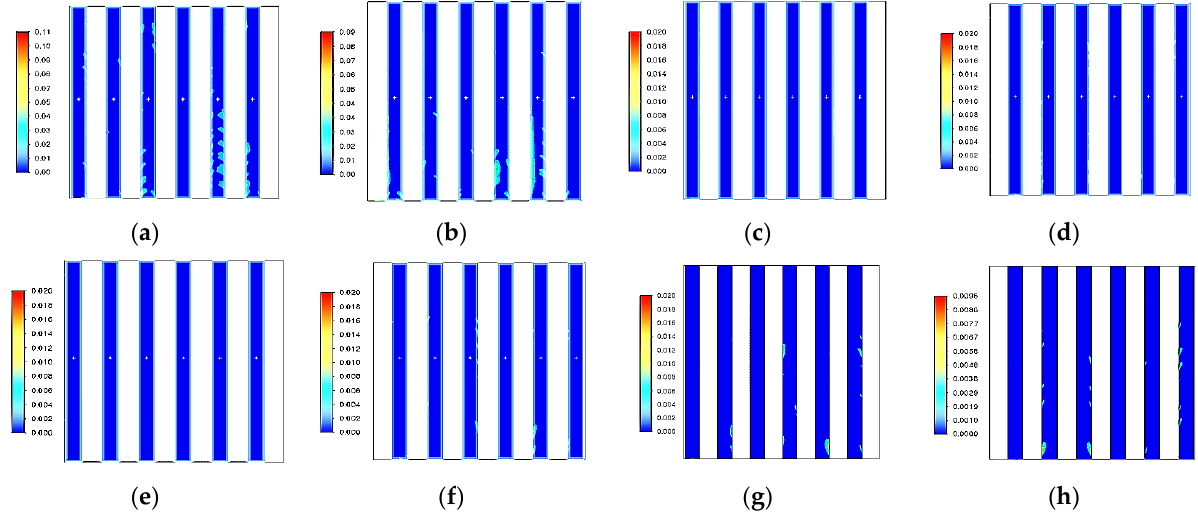
Figure 7. The regions of erosive wear rates W e , mm/year for different rows of arc-shaped elements in the separator at particle diameter d p = 20 µm (frontal view, as seen from the inlet). ( a ) row 1. ( b ) row 2. ( c ) row 3. ( d ) row 4. ( e ) row 5. ( f ) row 6. ( g ) row 7. ( h ) row 8.